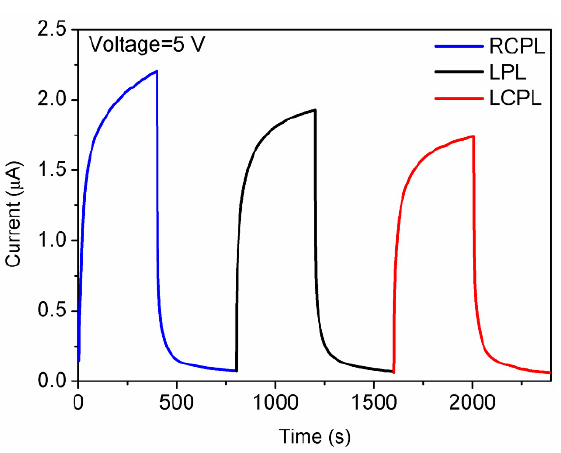
Figure 8. I-t characteristics with different photocurrent responses for different polarization states.